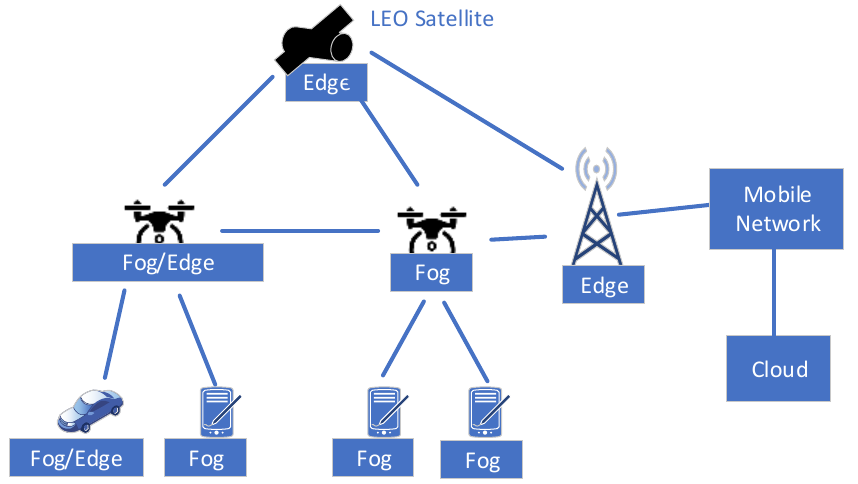
Figure 4. VMCS Cloud, Edge and Fog node placement (an example).